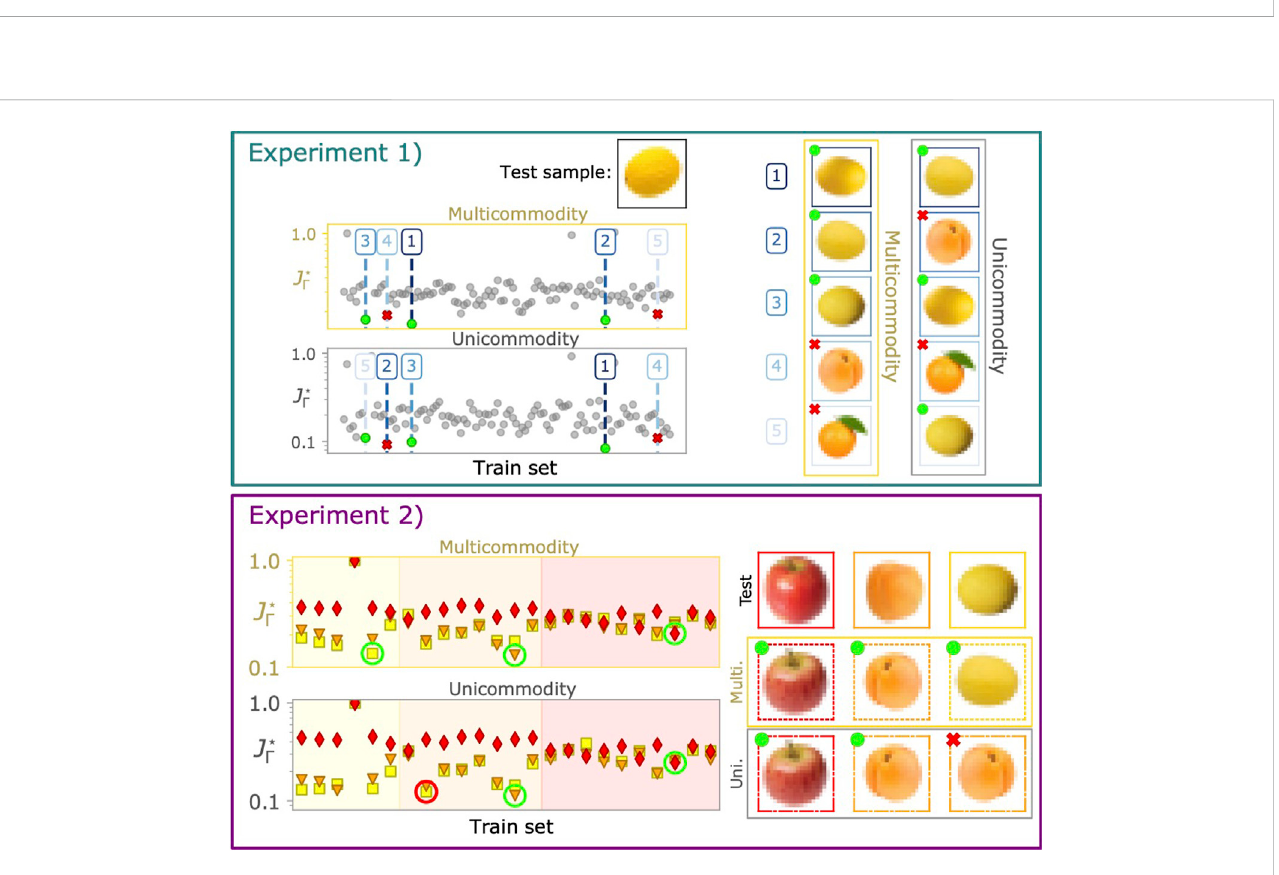
FIGURE 3 Evaluating the effect of colors. Experiment 1: The top black-framed image is the one to be classi fi ed. Predictions given by the multicommodity and unicommodity dynamics (those with lower J + Γ ) are shown on the right side of the panel and are displayed in a sorted fashion from worst to best (from bottom to top). Experiment 2: The top right samples are the three test images to be classi fi ed. Middle and bottom rows are predictions given by the two dynamics. Markers, backgrounds, and test images shared a color code: red for apples, orange for apricots, and yellow for melons. In both panels, green circles and redcrossesareusedtohighlightclassi fi edandmisclassi fi edimages,respectively.Allalgorithmsareexecutedwiththeiroptimalcon fi